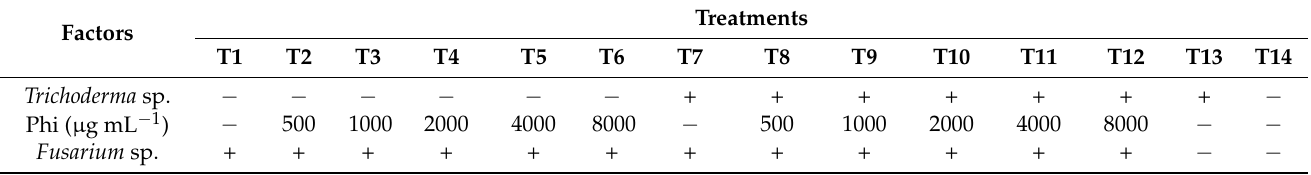
Table 1. Treatments evaluated to test the compatibility of Trichoderma sp. and phosphite (Phi) in the control of the Fusarium species complex causing pokkah boeng in sugarcane ( Saccharum spp.). Factors